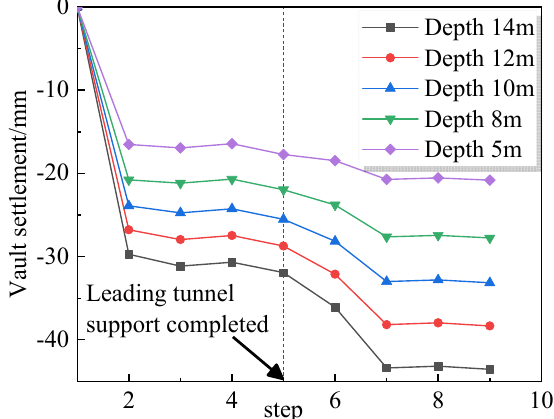
Figure 15. Vault settlement of the leading tunnel at position 4 of the soil-rock interface with construction steps.